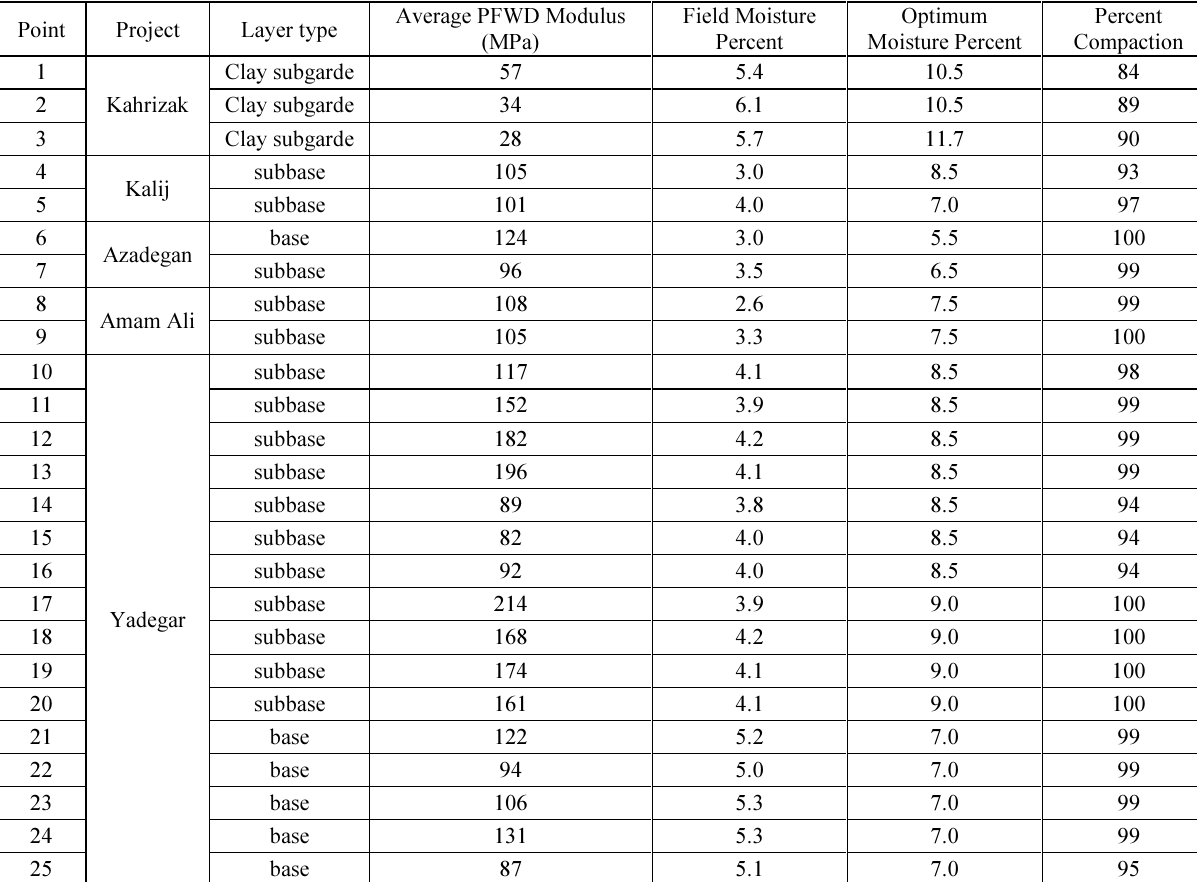
Table 2. Summary of field testing